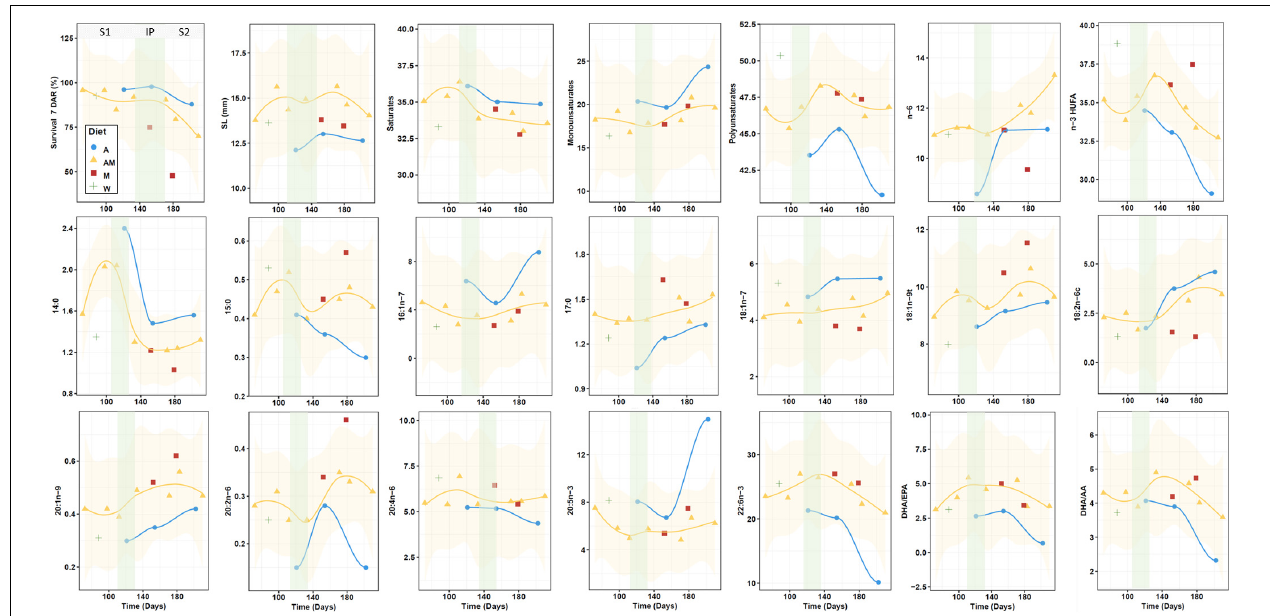
FIGURE 7 | Progressive changes in survival at 7 DAR, length (SL), fatty acids (area percentage), and FA ratios along the breeding period in newborn released by seahorses (Wild and groups A, AM and M). Smoothed trends are shown for groups AM (95% confidence intervals also shown) and A. Green shadowed areas show inflection periods indicating a remarkable change (transition from stage 1 to stage 2). Stages: S1 (Stage 1), IP (Inflection period), and S2 (Stage